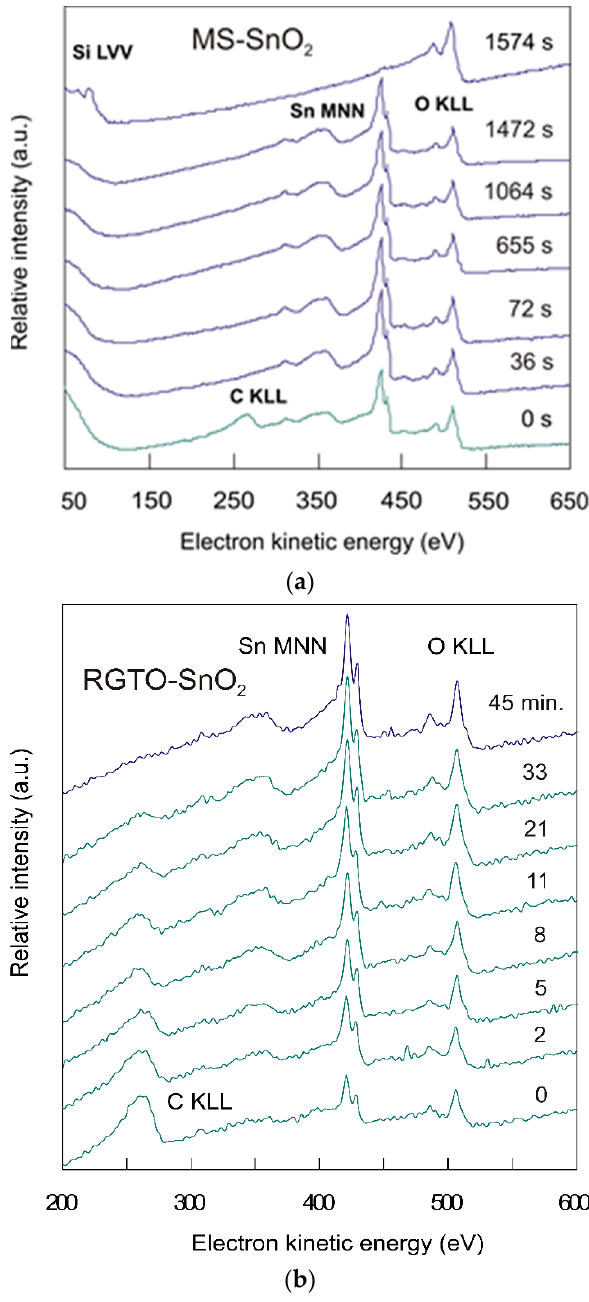
Figure 7. Integral Auger spectra (N(E) = f(E kin )) for MS-SnO 2 sample measured ( a ) during etching of the tin dioxide layer from the outermost surface to silicon dioxide substrate and for RGTO-SnO 2 sample ( b ) in the near-surface